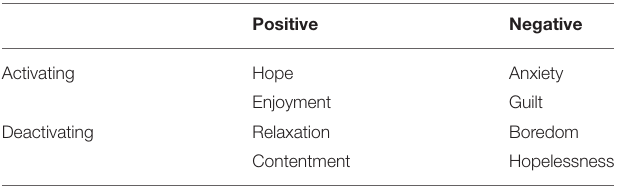
TABLE 1 | A two-dimensional taxonomy of achievement emotions (adapted from Pekrun et al.,